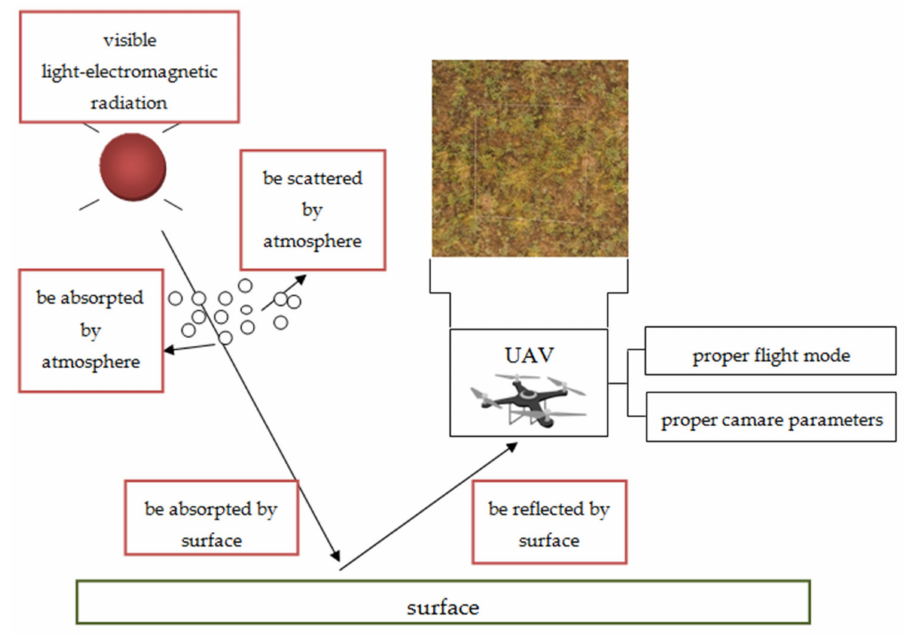
Figure 9. The conceptual model of UAV monitoring the soil